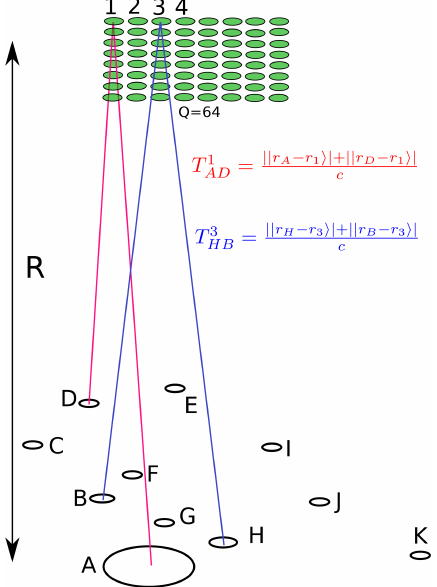
Figure 6. Example of multiple-input–multiple-output (MIMO) radar and plasma volume in its line of